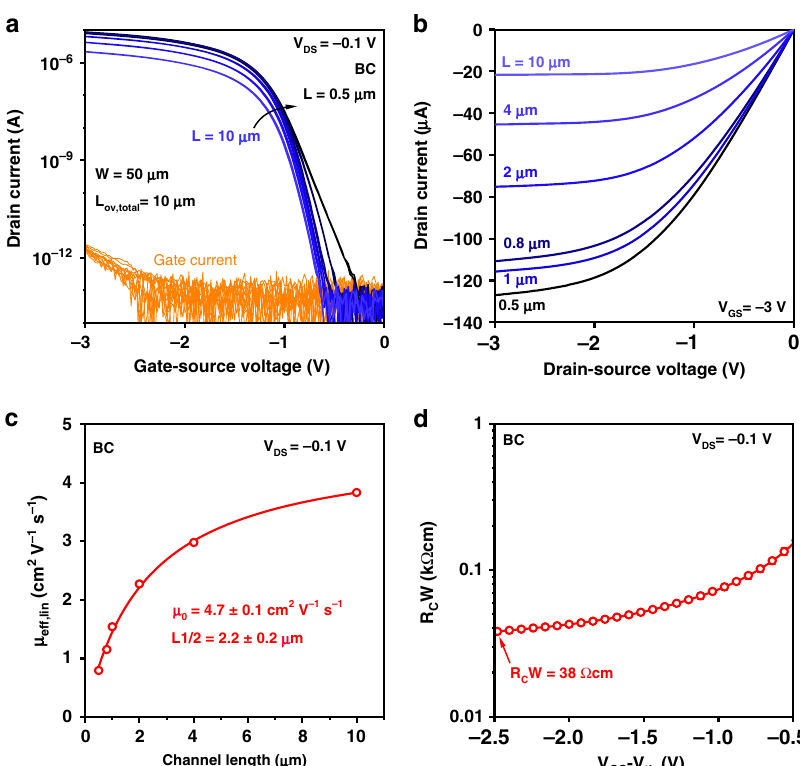
Fig. 7 Short-channel bottom-contact DPh-DNTT TFTs on fl exible PEN substrates. The TFTs have a gate-dielectric thickness of 5.3 nm, channel lengths ranging from 0.5 to 10 µ m, a channel width of 50 µ m, and a total gate-to-contact overlap of 10 µ m. a Transfer characteristics measured in the linear regime of operation ( V DS = − 0.1 V). b Output characteristics of the same TFTs measured at a gate-source voltage of − 3 V. c Effective carrier mobility ( µ eff ) plotted as a function of the channel length. The error bars correspond to the standard error from the linear regression at each gate-overdrive voltage. d Channel- width-normalized contact resistance ( R C W ) plotted as a function of the gate-overdrive voltage ( V GS − V th )